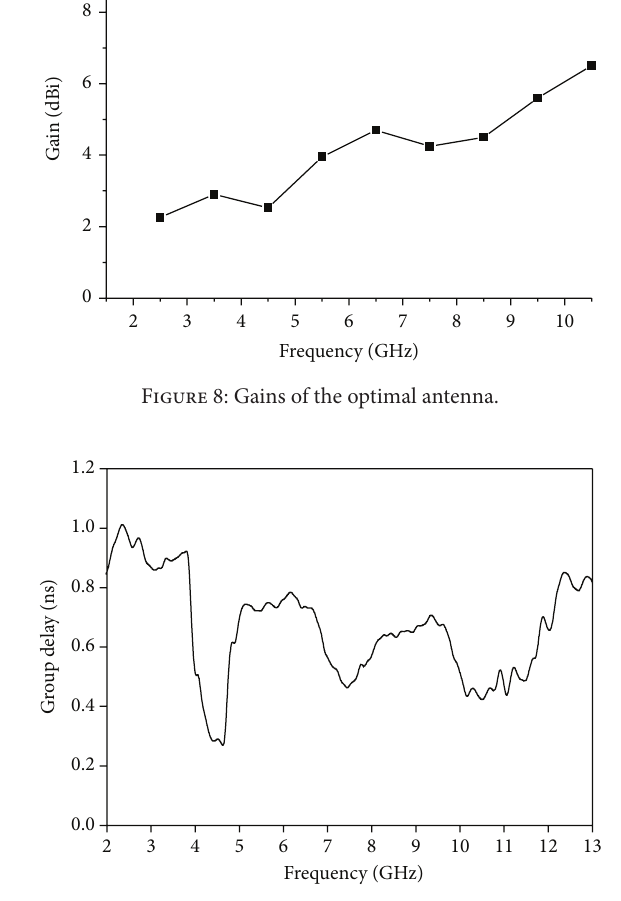
Figure 9: Group delay of the optimal